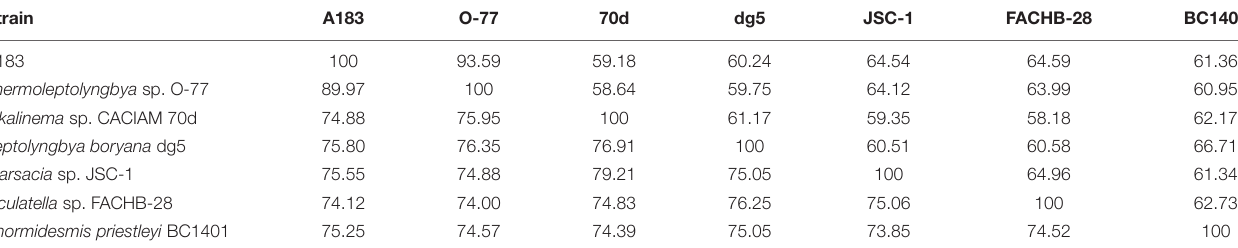
The numbers above and below the diagonal indicate the AAI and ANI values (%), respectively.